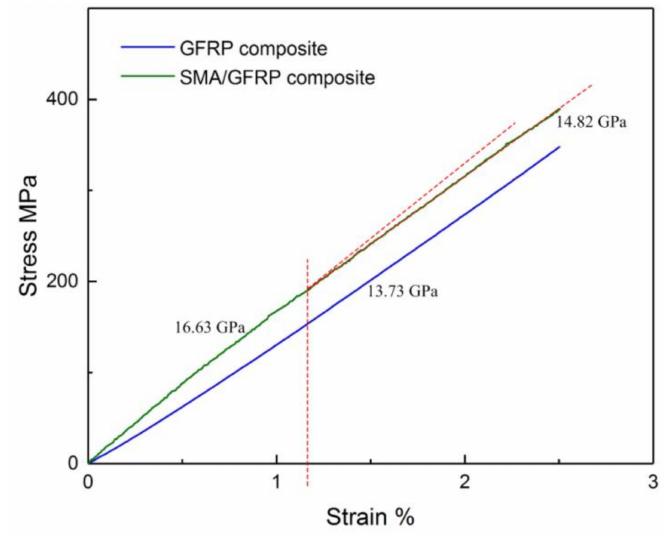
Figure 7. Stress–strain curves of plain-woven GFRP composites with and without SMA wires.